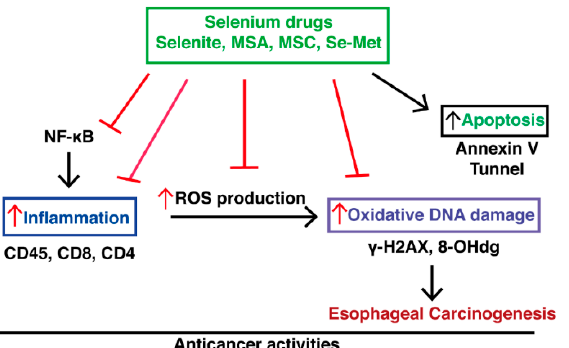
Figure 6. A detail mechanistic illustration showing the action of selenium against ESCC.